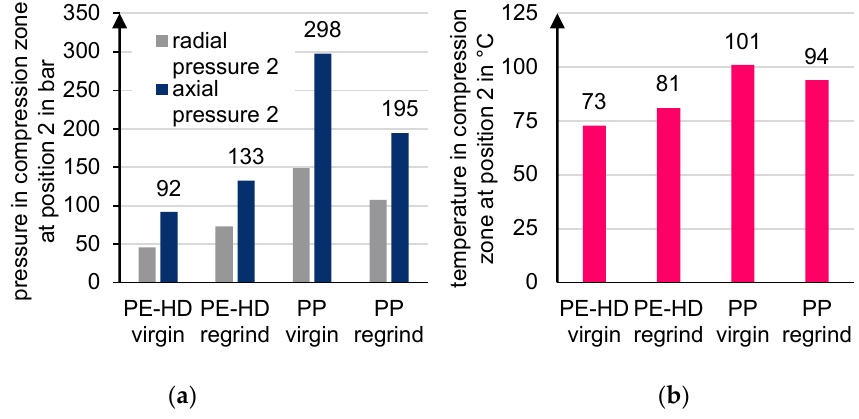
Figure 19. ( a ) Radial and axial forces and ( b ) temperatures in the feed zone.